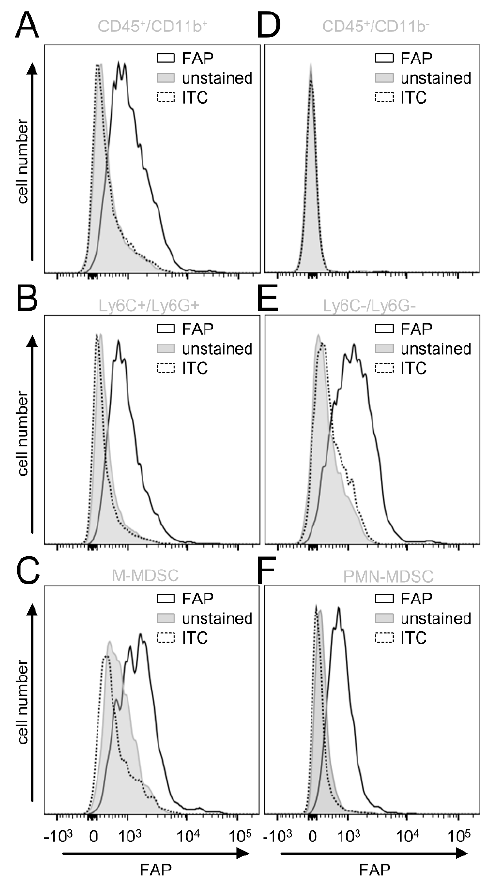
Figure 5. Analysis of FAP expression by tumor-infiltrating leukocytes. ( A – F ) Representative histograms of the flow cytometry analysis of FAP expression by leukocytes (CD45+) found within primary tumor tissue. Samples were collected when tumors reached a size of 750 mm 3 , followed by enzymatic digestion to obtain a single-cell solution. Samples were then analyzed to show FAP expression (black solid line) using mouse anti-FAP IgG and PE-labeled anti-murine IgG Ab as primary and secondary Ab by CD11b-positive ( A ; CD45+/CD11b+) and CD11b-negative leukocytes ( D ; CD45+/CD11b − ), MDCS ( B ; CD45+/CD11+/Ly6C+/Ly6G+), CD11b+ leukocytes excepting MDSC ( E ; CD45+/CD11b+/Ly6C − /Ly6G − ), as well as two MDCS populations, M-MDSC ( C ; CD45+/CD11b+/Ly6C high /Ly6G − ) and PMN-MDCS ( F ; CD45+/CD11b+/Ly6C low /Ly6G+). Unstained cells (unstained; grey-filled curve) and cells incubated with appropriate isotype control (ITC, grey dashed line) served as negative controls.